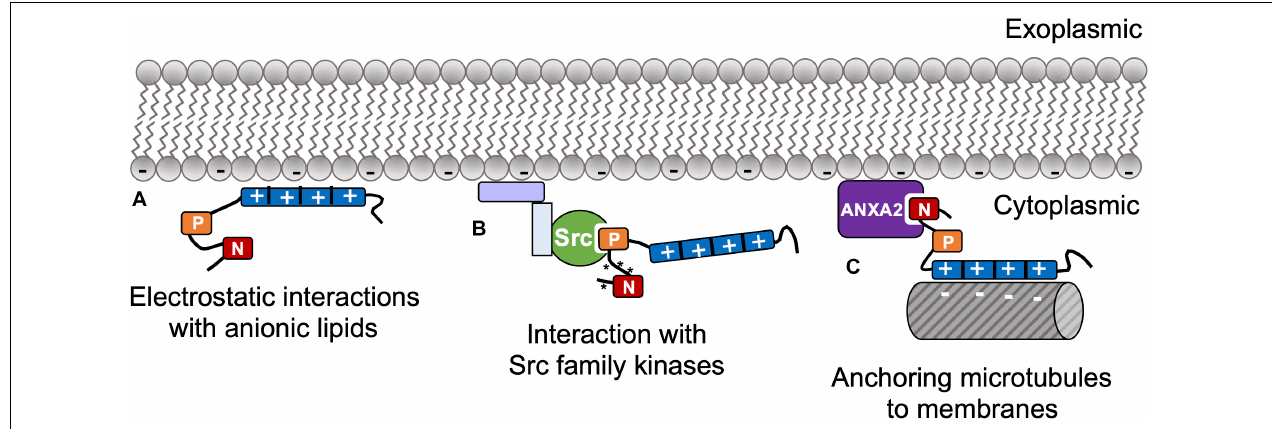
FIGURE 2 | (A) Tau has direct native interactions with membranes including electrostatic affinity of basic side chains around the repeat domain with anionic lipids through the RD. Tau also has indirect membrane interactions via membrane-associated proteins, e.g., (B) PXXP motif interactions with SH3 domains in Src family kinases, which regulate tau’s N-terminal phosphorylation (* indicates phosphorylation); and (C) anchoring microtubules to the plasma membrane via N-terminal interactions with Annexin A2 (ANXA2).